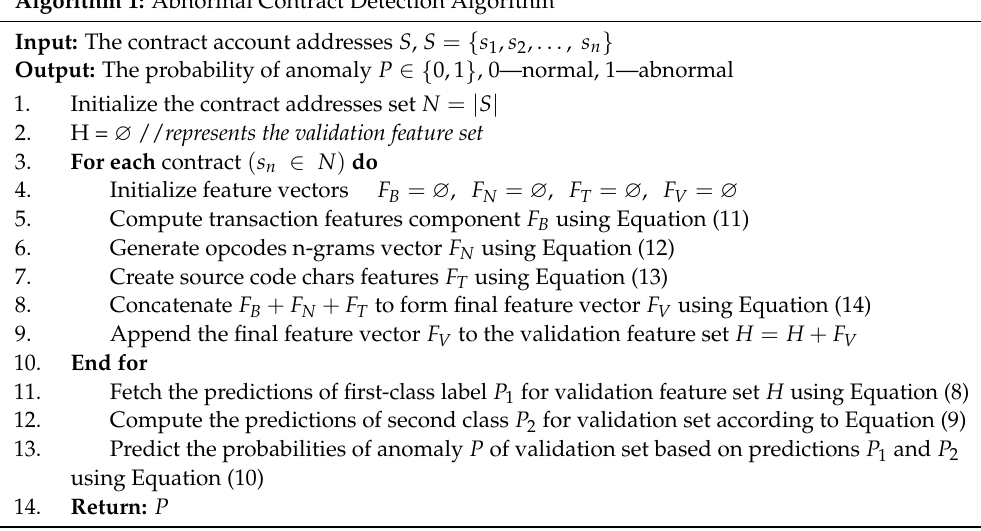
Algorithm 1: Abnormal Contract Detection